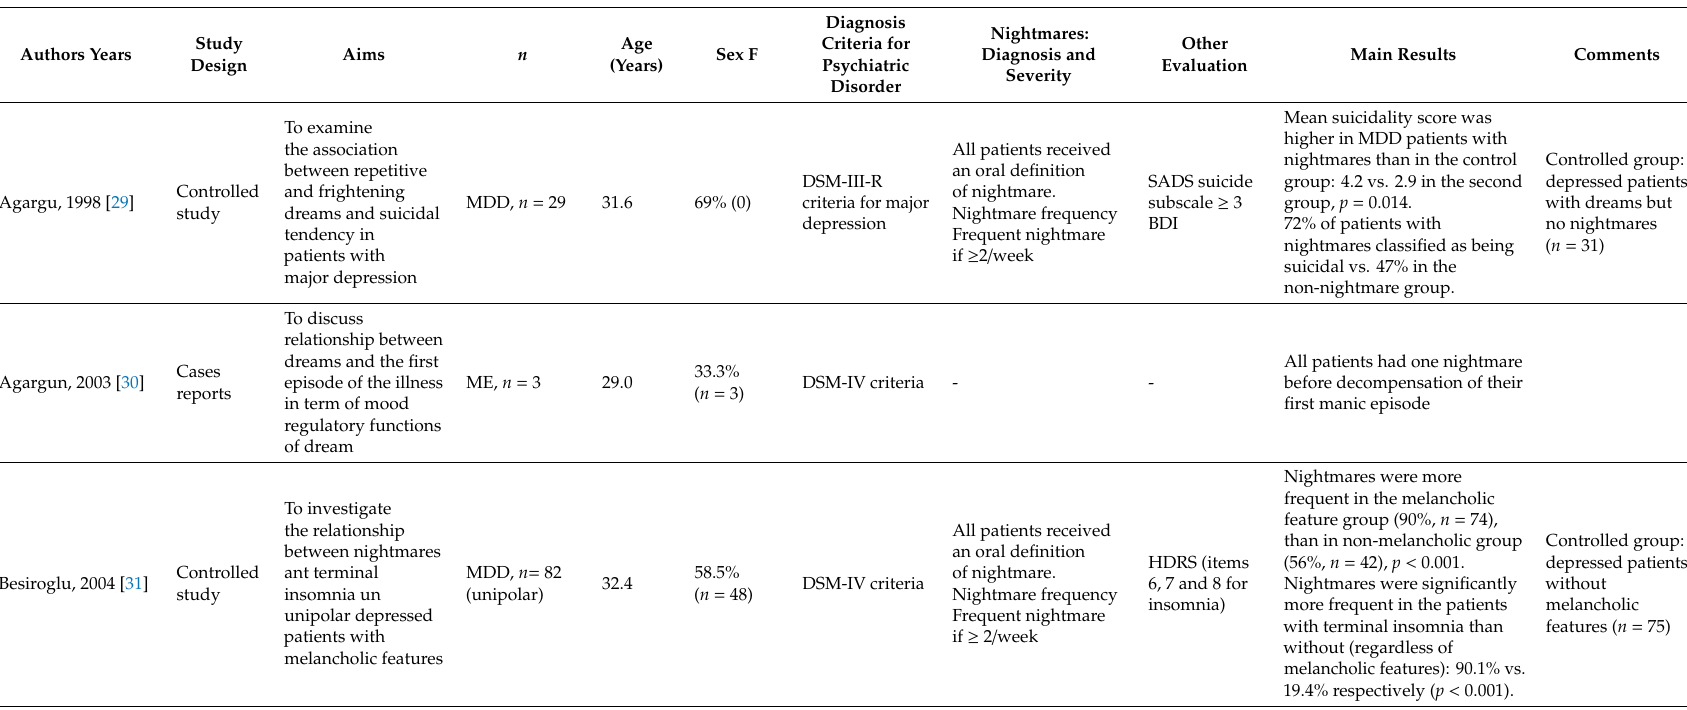
Table 1. Mood disorders and